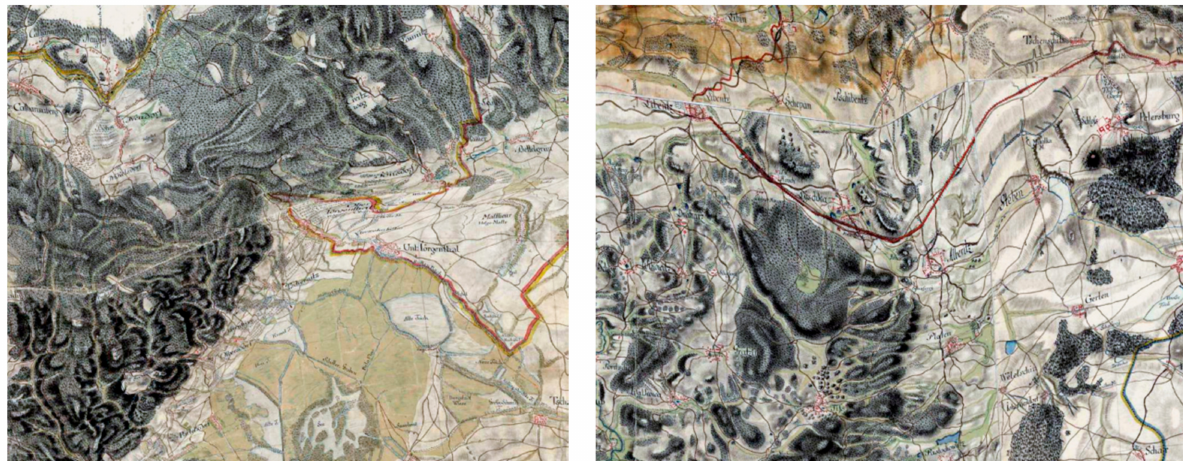
Figure 3. Breakages of line objects in the map mosaic on Mapire.eu.